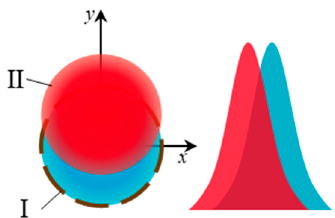
Figure 3. Position mismatch between aperture and measurement beam in interferometry.